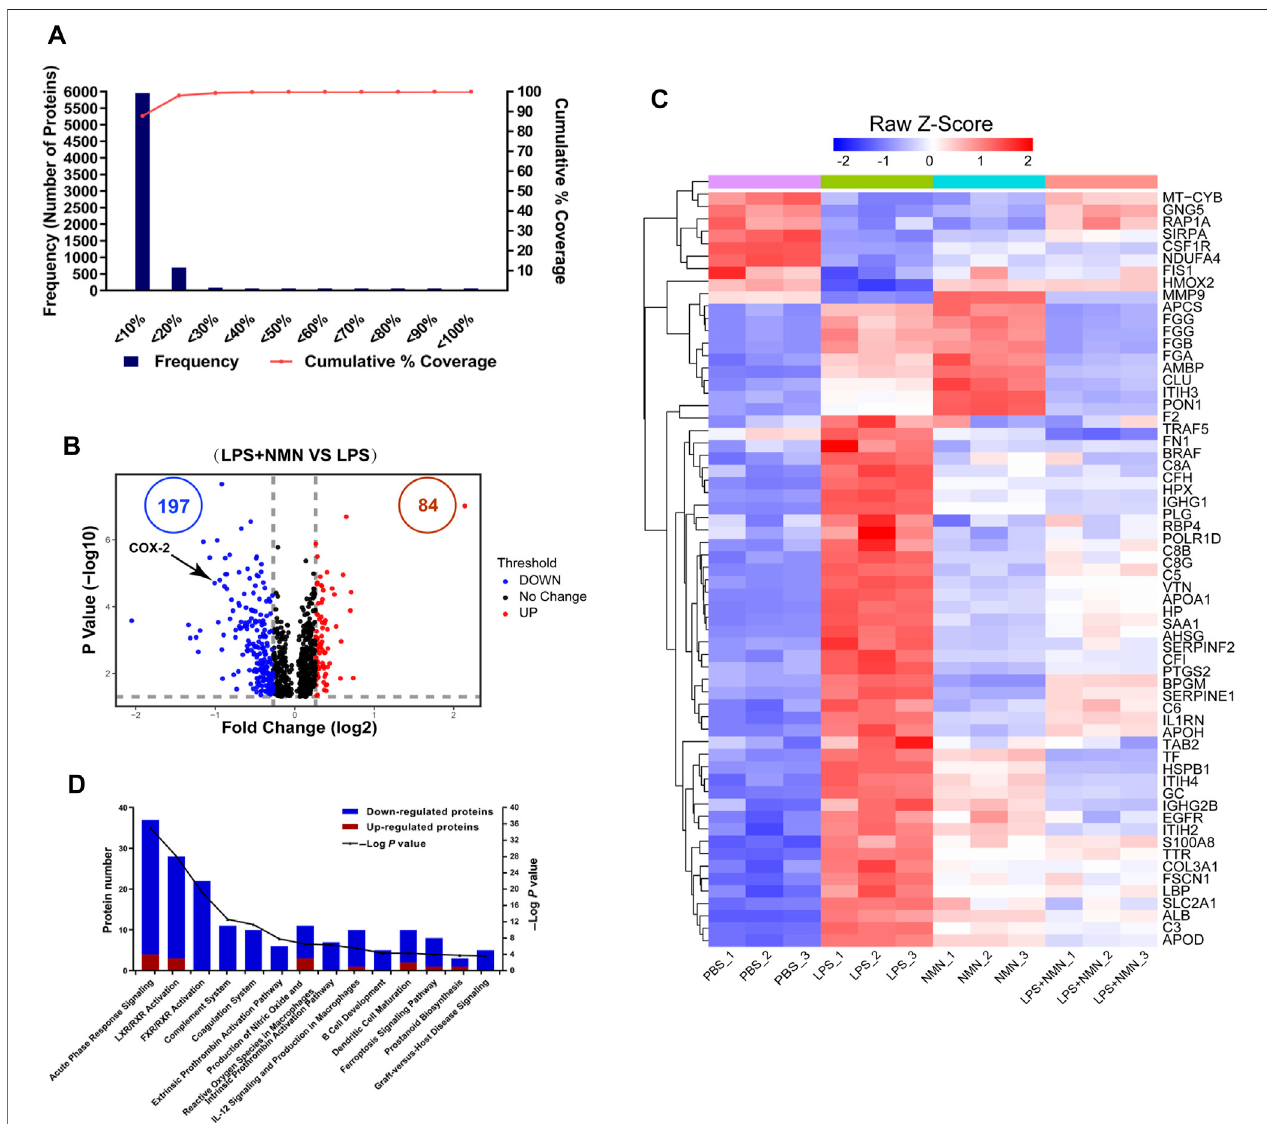
FIGURE 4 | Functional classi fi cation of differentially expressed proteins (DEPs) from proteomics analysis of LPS-NMN-treated RAW264.7 cells as compared with LPS-treated cells. (A) Experimental variations of proteomics analysis in this study. (B) The volcano plot shows differentially expressed proteins (DEPs) in LPS-NMN- treated cells as compared with LPS-treated cells. The red and blue dots indicate the signi fi cantly changed proteins with fold-change > 1.2 or < 0.83 and p value < 0.05. COX-2ishighlighted. (C) 61differentiallyexpressedproteinswerefoundbasedonthe fi lterconditionsthatfoldchange(LPSandNMNco-treatedcellsversusLPS- treatedcells) > 1.2or < 0.83-foldinLPS-inducedactivatedmacrophages. (D) TheingenuitypathwayanalysisforDEPsinLPS-NMN-treatedcellsascomparingwithLPS- treated cells. The red bar represented up-regulated proteins, and blue represented down-regulated (LPS-treated cells versus untreated cells > 1.2-fold or < 0.83, P <